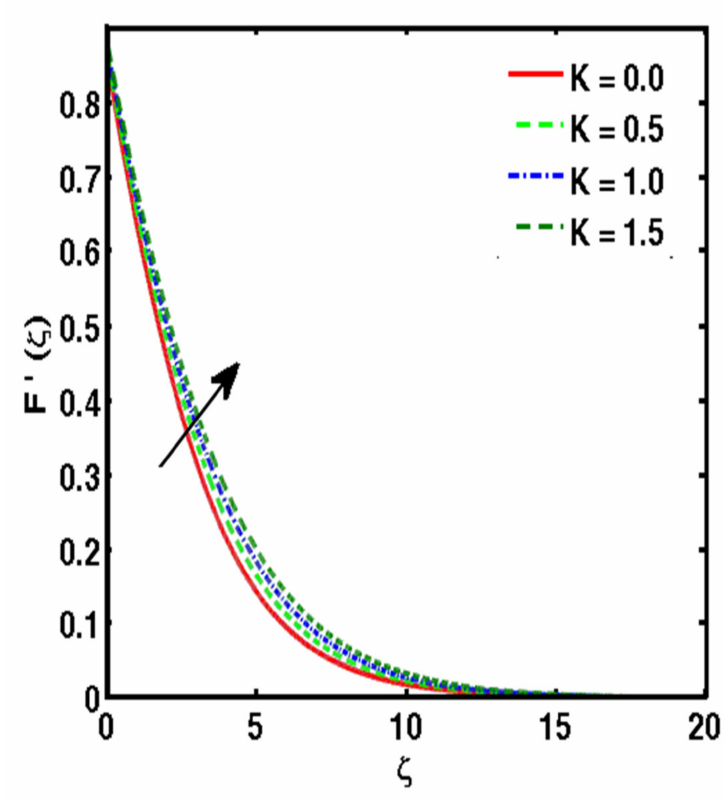
Figure 5. Variation of K and F (cid:48) ( ζ ) .